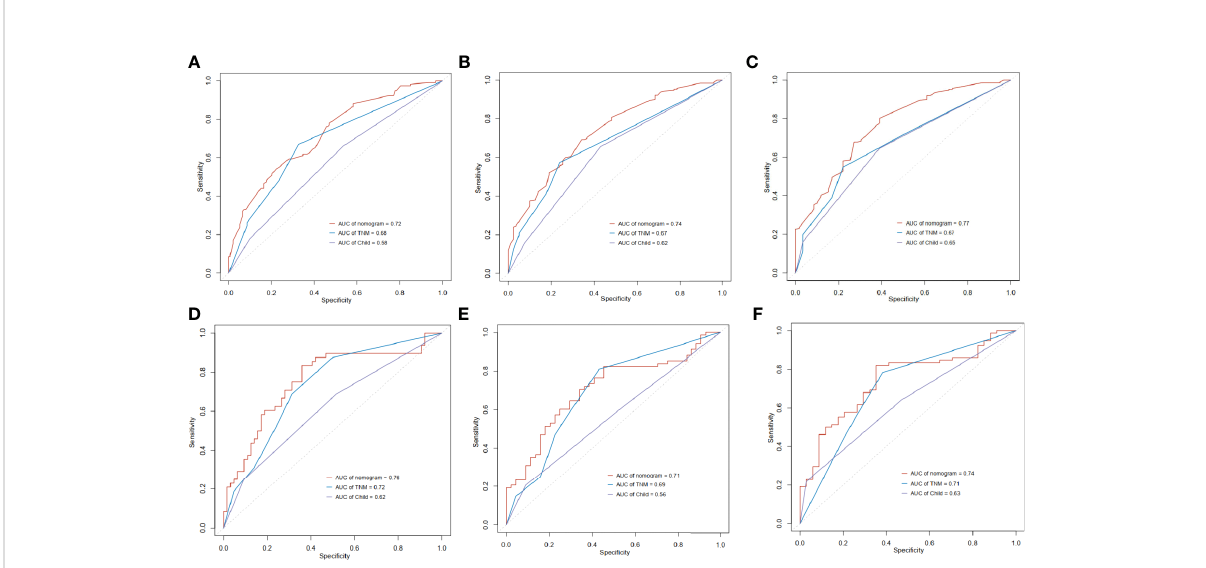
FIGURE 5 Time-dependent receiver operating characteristic (ROC) curves of the nomogram score, model based on TNM stage and model based on Child-Pugh. (A) 1 year in training cohort; (B) 3 years in training cohort; (C) 5 years in training cohort; (D) 1 year in validation cohort; (E) 3 years in validation cohort; (F) 5 years in validation